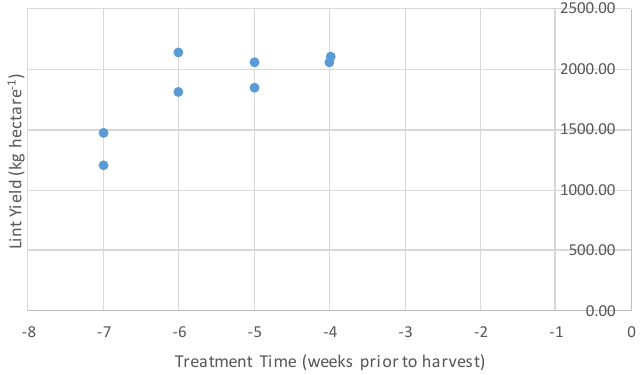
Figure 17. Effect of treatment timing on lint yield, for field cotton grown under commercial practices common to deficit irrigated cotton in West Texas, United States.